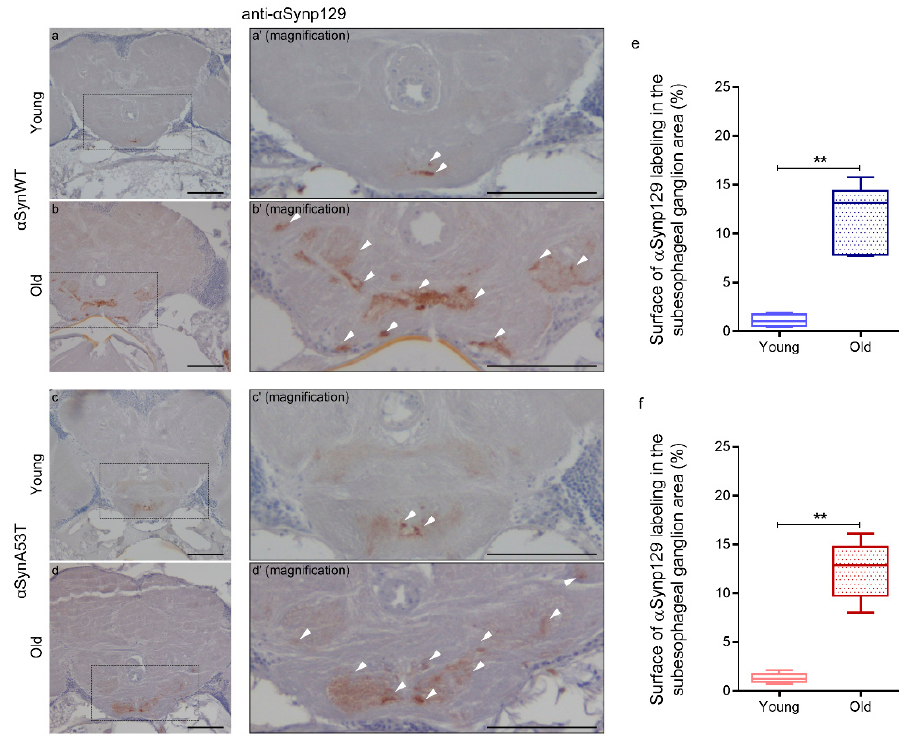
Figure 3. Age-dependent increase of α Synp129 in α Syn-expressing flies. Representative immunohistochemistry paraffin-embedded brains stained with an anti- α Synp129 (EP1536Y) antibody on young (5 day-old) ( a , c ) or old (60 day-old) ( b , d ) flies expressing α SynWT ( a , b ) or α SynA53T ( c , d ). Magnification of area indicated in ( a – d ) are shown in ( a’ – d’ ). Note that localized staining of the α Synp129 is observed in the suboesophageal ganglion area as well as an increased detectability in older flies. White arrowheads indicate α Synp129 deposits. Scale bar represents 30 µ m. Quantifications show the surface of α Synp129 labeling (EP1536Y antibody) in subesophageal ganglion area for α SynWT ( e ) or α SynA53T ( f ) in young (5- or 10-day-old) or old (50- or 60-day-old) flies. In the box and whisker plots in ( e , f ), boxes extend from the first to the third quartile, the line inside the boxes shows the median and the whiskers represent the min/max value of independent experiments: α SynWT (n = 4 for young, n = 6 for old) or α SynA53T (n = 5 for young, n = 6 for old). p -values of the group differences were calculated using Mann–Whitney test (** p = 0.0095 for α SynWT and ** p = 0.0043 for α SynA53T). Flies were raised on standard corn meal food supplemented with